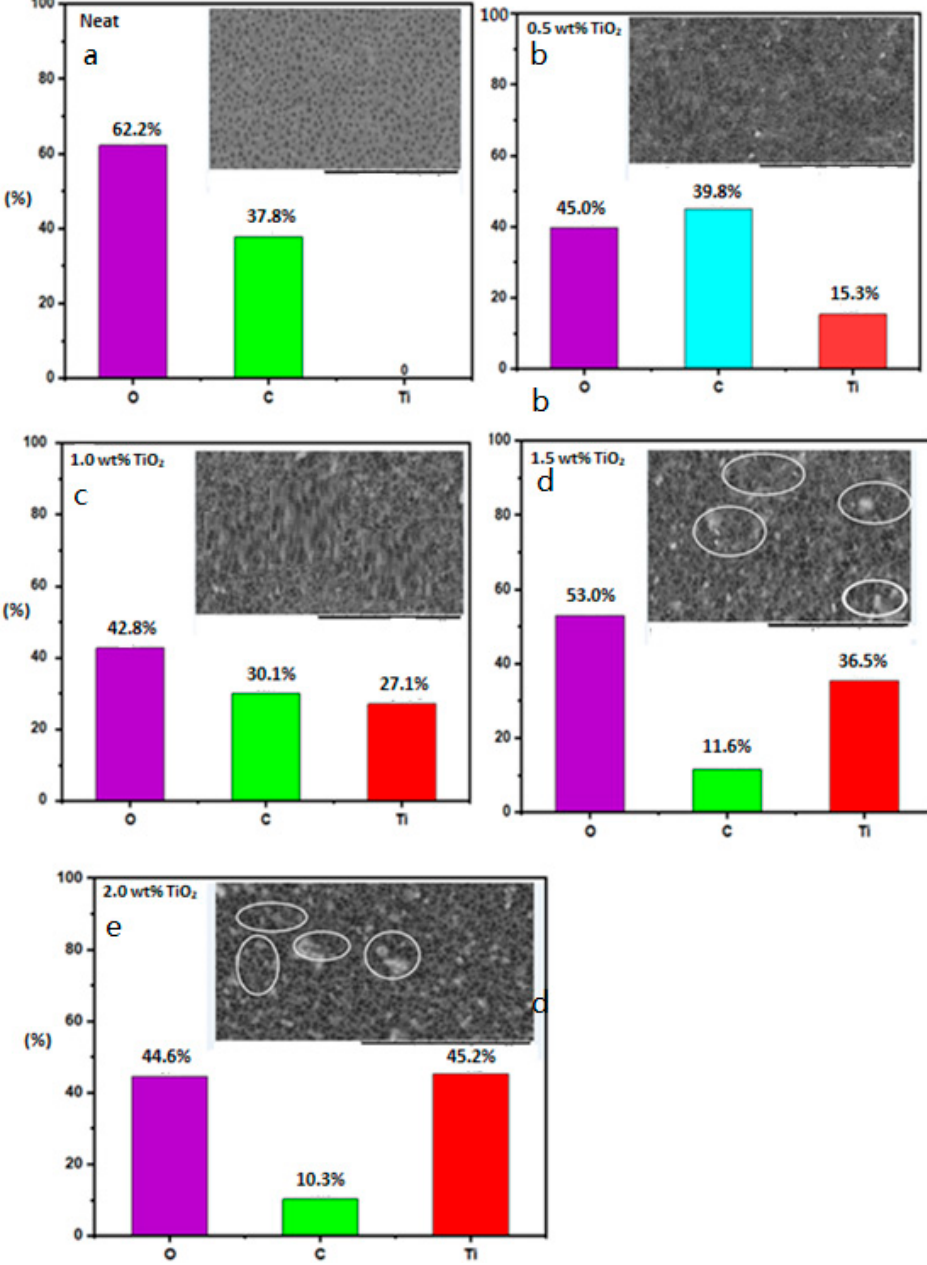
Figure 2. SEM/elemental composition of the PVDF/PVP membrane at different dosages of TiO 2 : ( a ) Figure 2. SEM / elemental composition of the PVDF / PVP membrane at di ff erent dosages of TiO 2 : ( a ) neat, neat, ( b ) 0.5, ( c ) 1.0, ( d ) 1.5, and ( e ) 2.0 wt%. ( b ) 0.5, ( c ) 1.0, ( d ) 1.5, and ( e ) 2.0